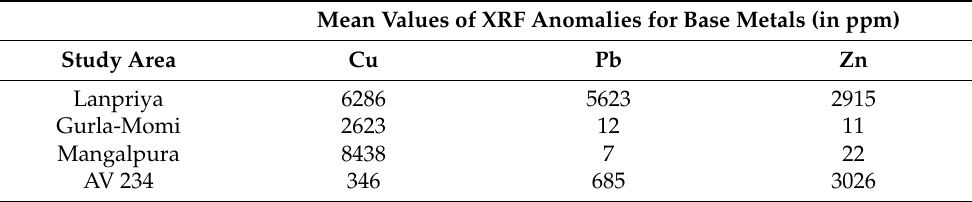
Figure 20. ( a ) Photomicrograph of sulfide (collected under reflected light) occurring within Quartzite in Mangalpura area. ( b ) Photomicrograph of sulfide (collected under reflected light) occurring within Balykhera area. ( c) Photomicrograph of sulfide (collected under reflected light) occurring within Calcareous Silicates in Baran area. ( d ) Photomicrograph of Gossanized magnetite rich quartzite (under reflected light) near Gurla village. Table 3. XRF values of representative samples collected from few important areas around